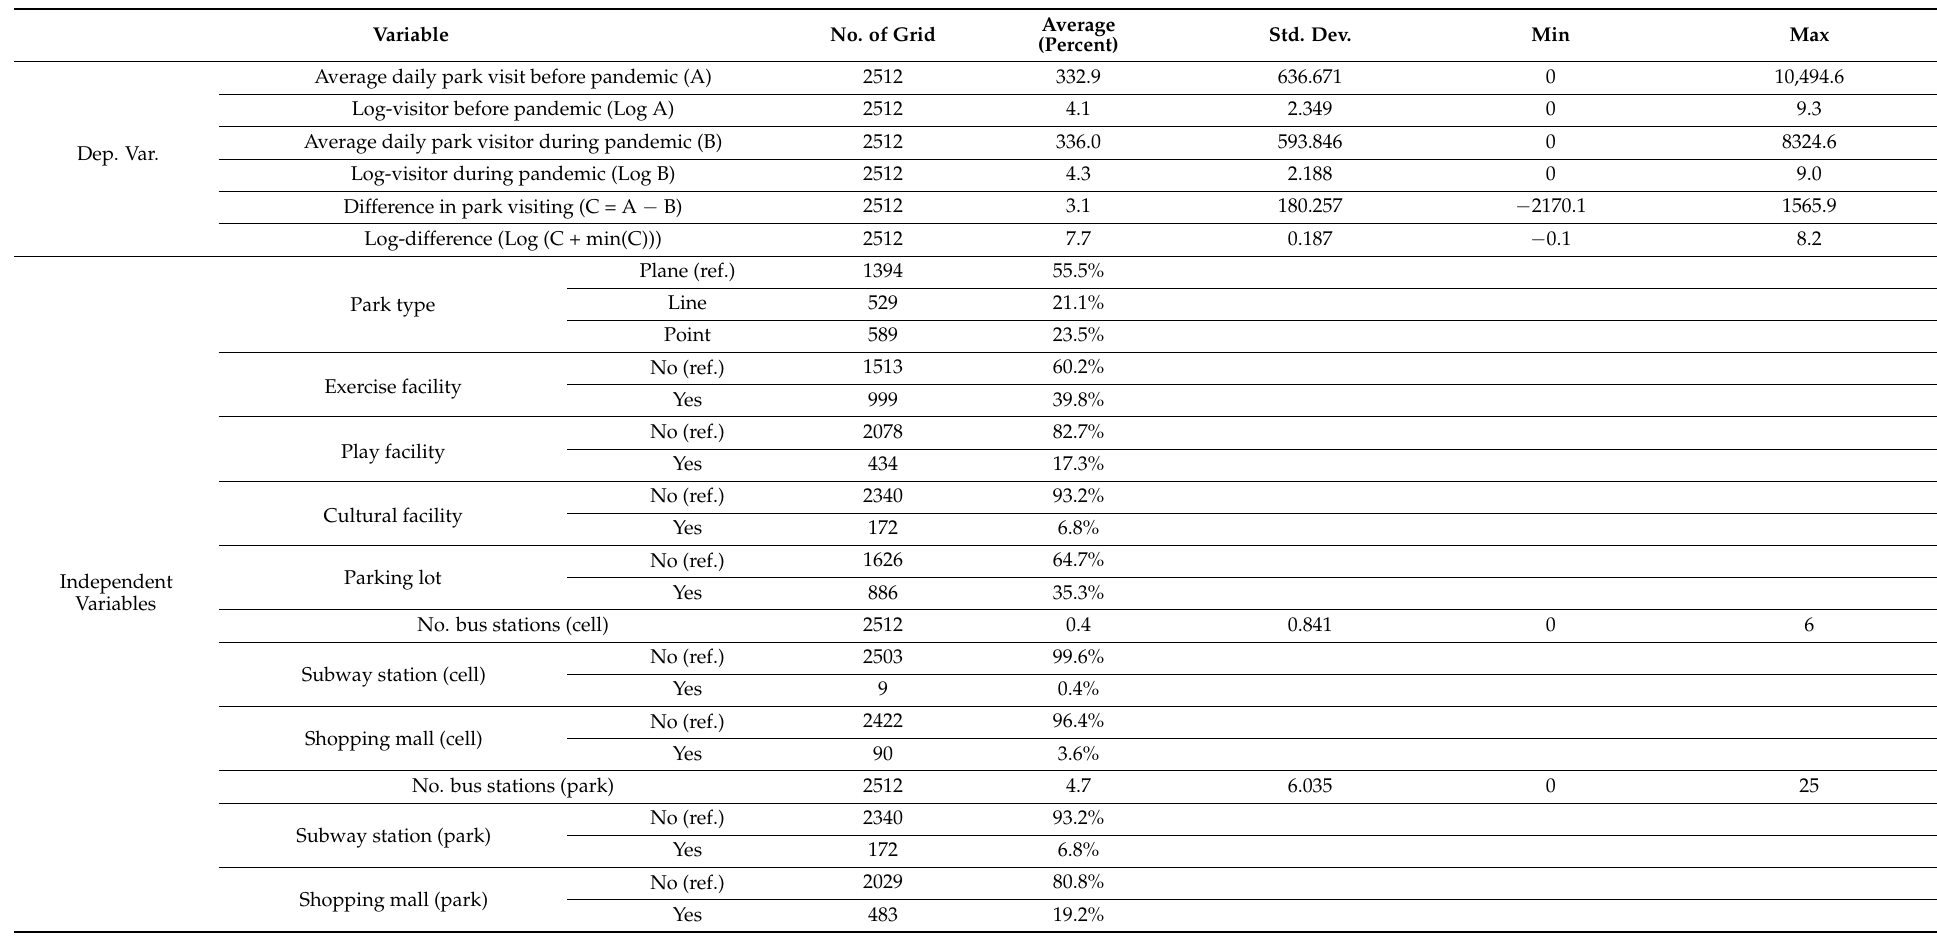
Table 1. Summary